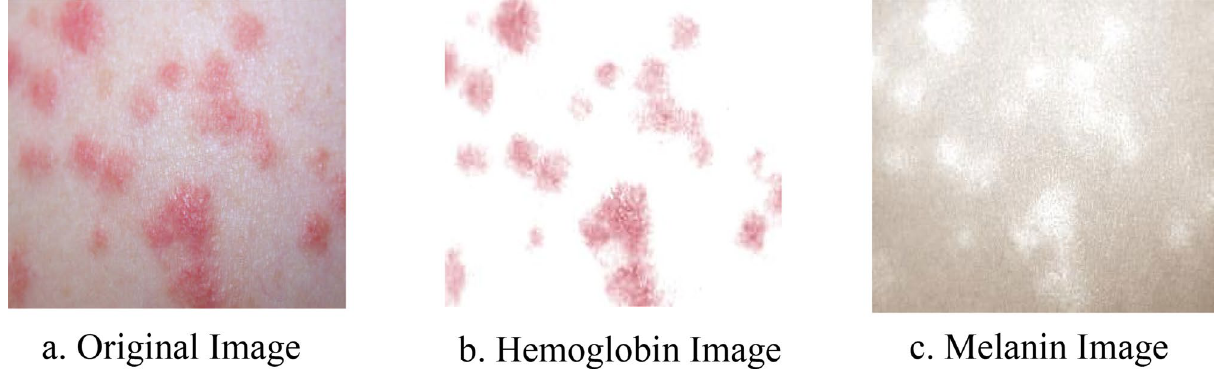
Figure 6. Decomposed result of skin. The original image is decomposed into its hemoglobin and melanin constituents through